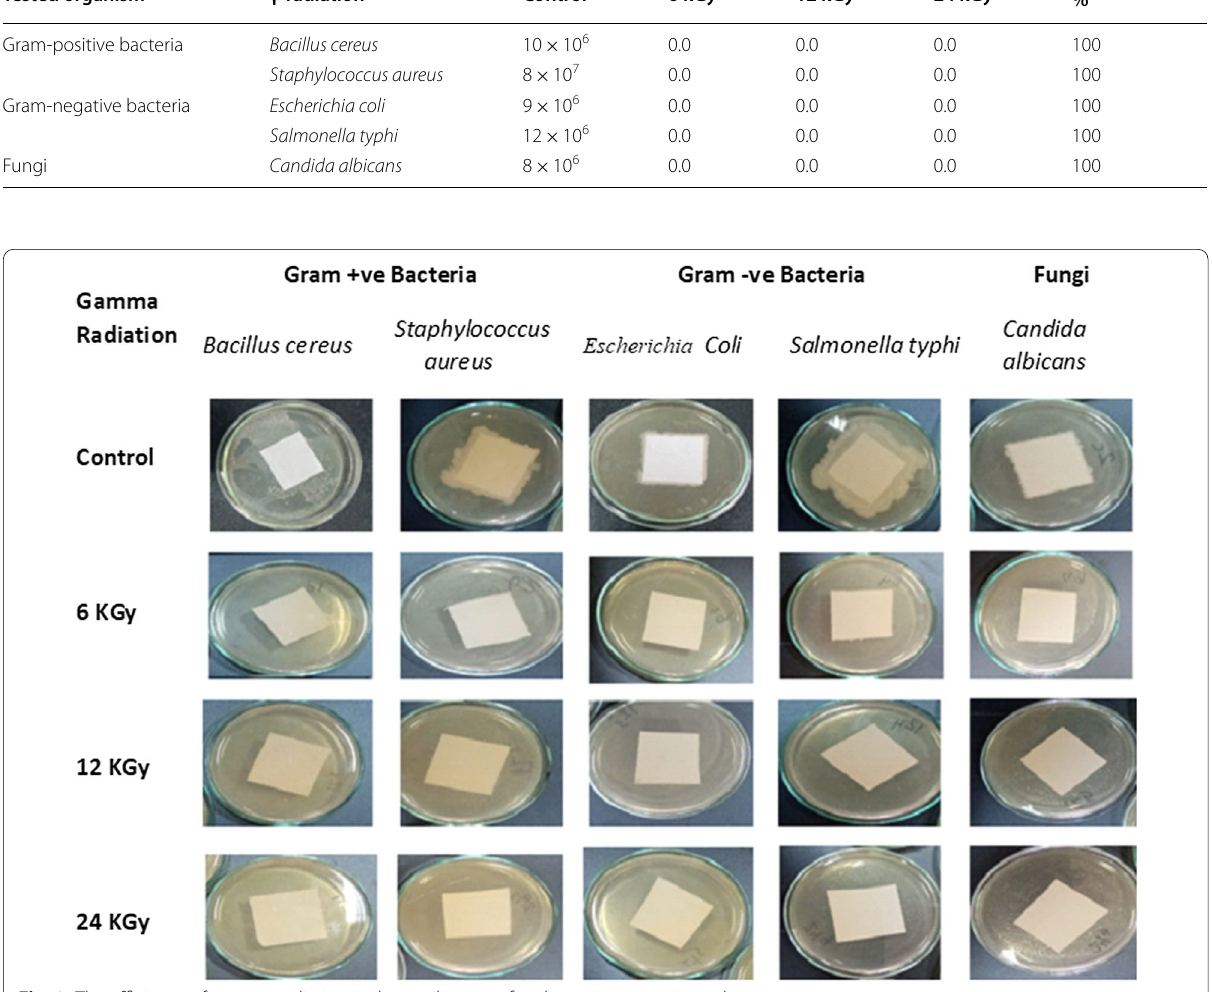
Fig. 3 The efficiency of gamma radiation in the sterilization of pathogenic contaminated